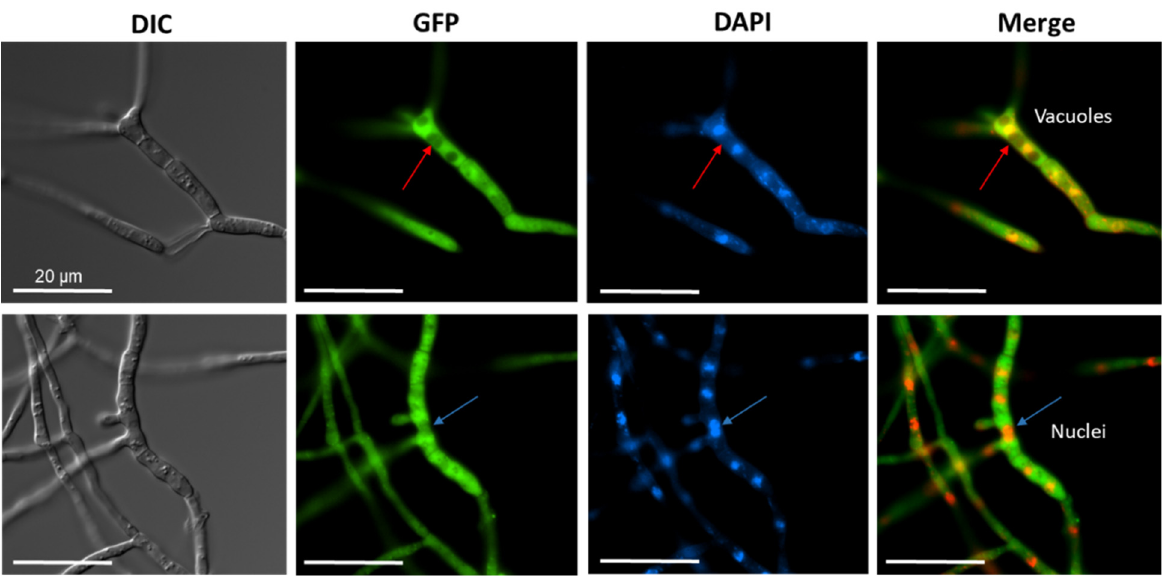
Figure 4. Fluorescence microscopy to demonstrate the cytoplasmic localization of CCAA. The ccaA gene was fused to the gfp gene (EGFP) at the 3 ′ terminus. DAPI staining was performed for the visualization of nuclei and mitochondria. Red arrows indicate putative vacuoles, blue arrows indicate nuclei. Merged images with EGFP filter and DAPI filter indicate the cytoplasmic localization of CCAA. All scale bars correspond to 20 µm.